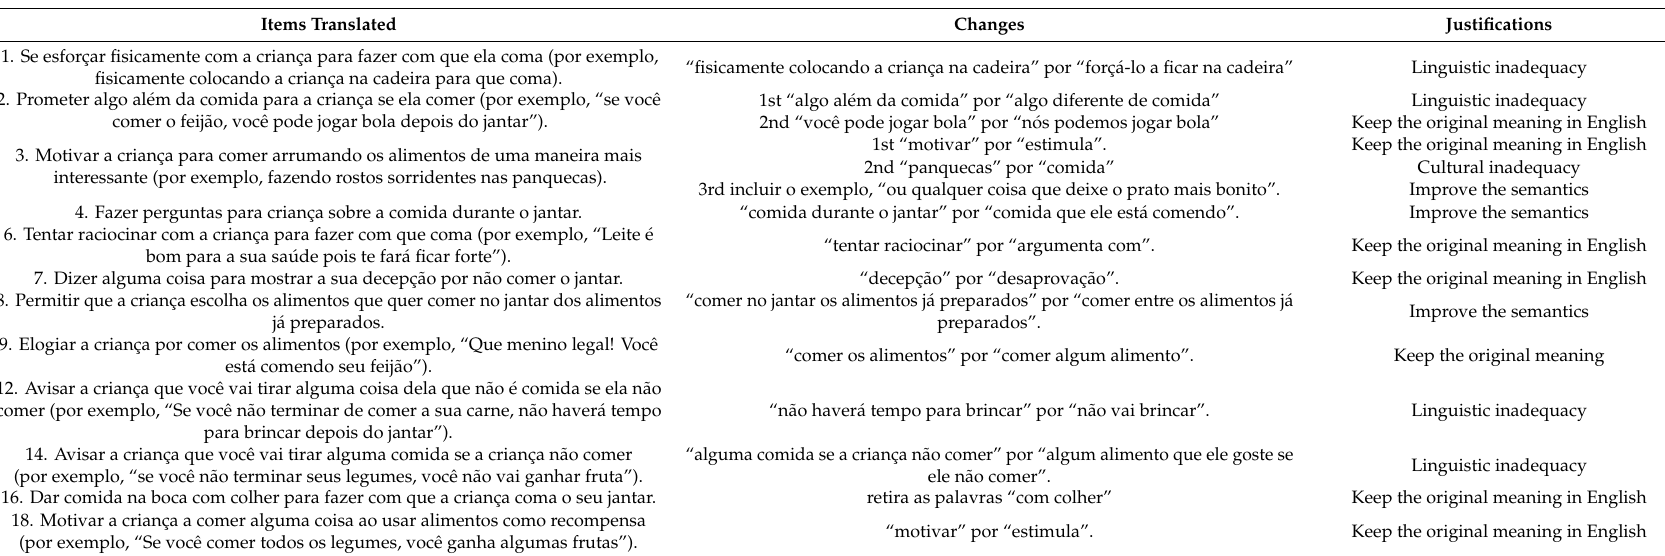
Table 2. Items translated from the original, changes, and justifications for the Brazilian final version (Rio de Janeiro) of the CFSQ, Family Health Clinic, Rio de Janeiro, Brazil,